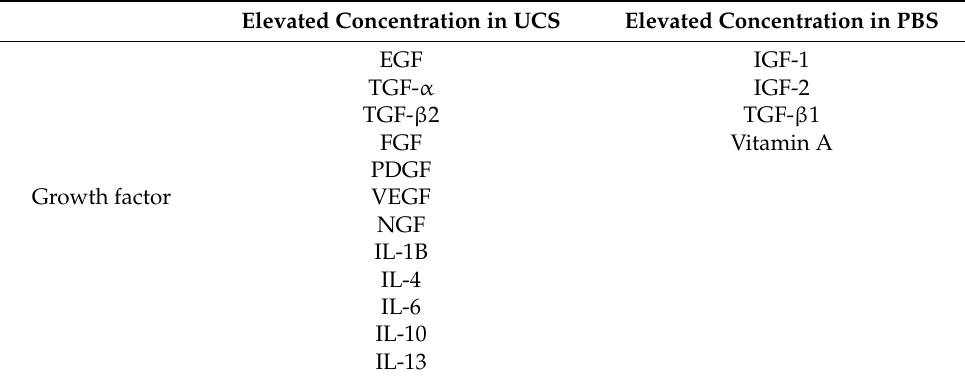
Table 1. Comparison of growth factor concentrations in UCS and